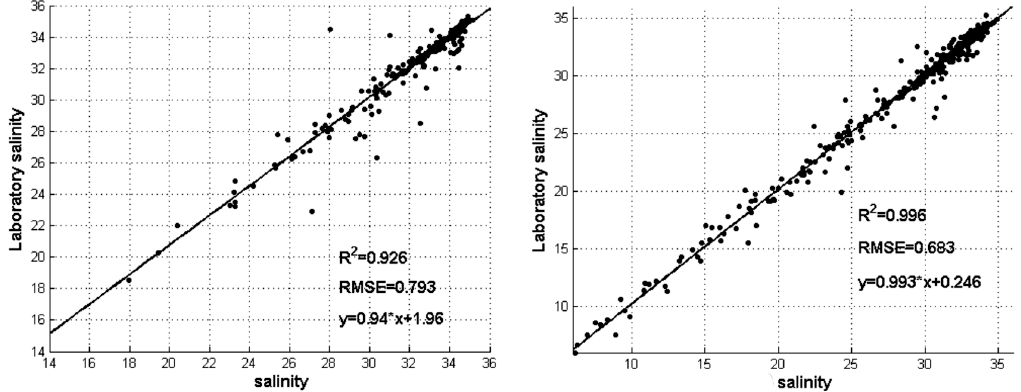
Figure 3. Comparison of FerryBox salinity measurements and water sample analyses in the laboratory for TorDania (left) and Lysbris (right).